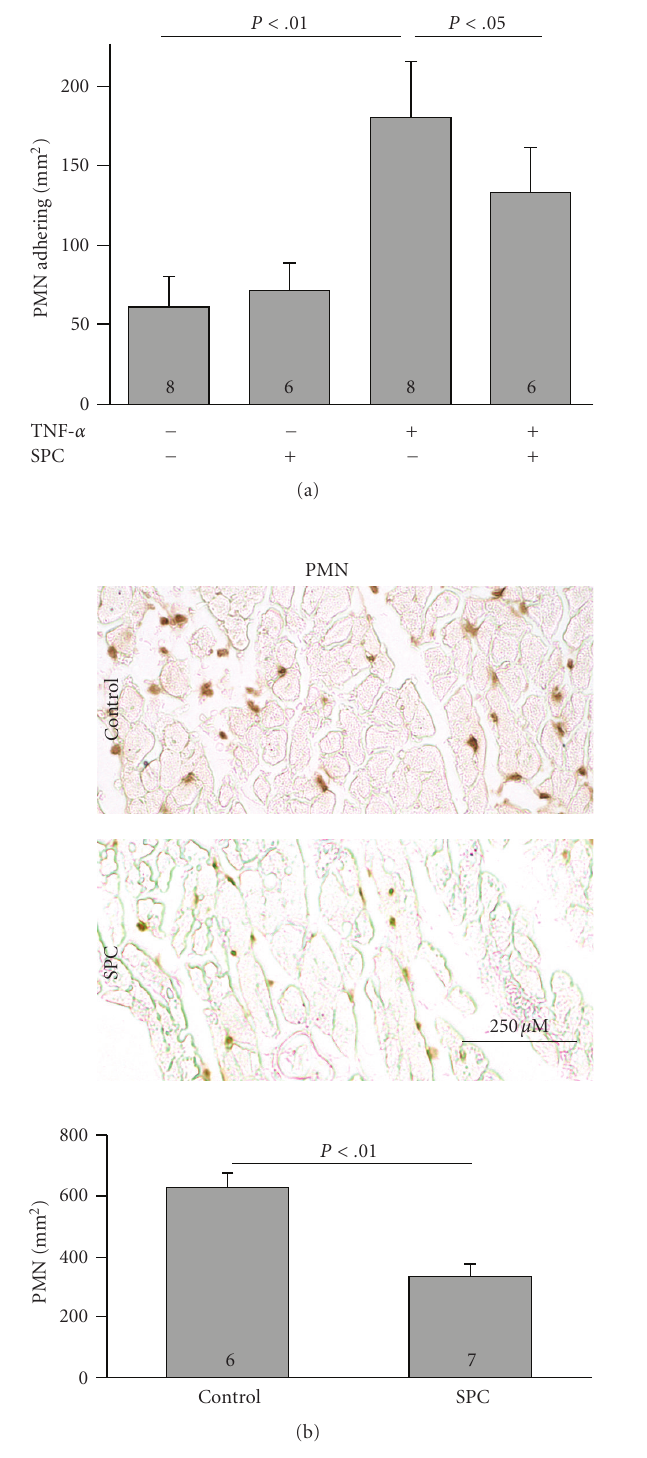
Figure 2: SPC inhibits PMN adhesion to activated endothelium under flow in vitro and PMN recruitment in the infarction area in vivo . (a) PMN adhesion to TNF- α -activated endothelial cells in vitro in the presence and absence of 10 μ M SPC as quanti- fied in a parallel-plate flow-chamber system. (b) Representative immunohistochemistry and morphometric quantification of PMN in infarcts of vehicle- and SPC-treated mice, respectively, 24 hours after ischemia/reperfusion.